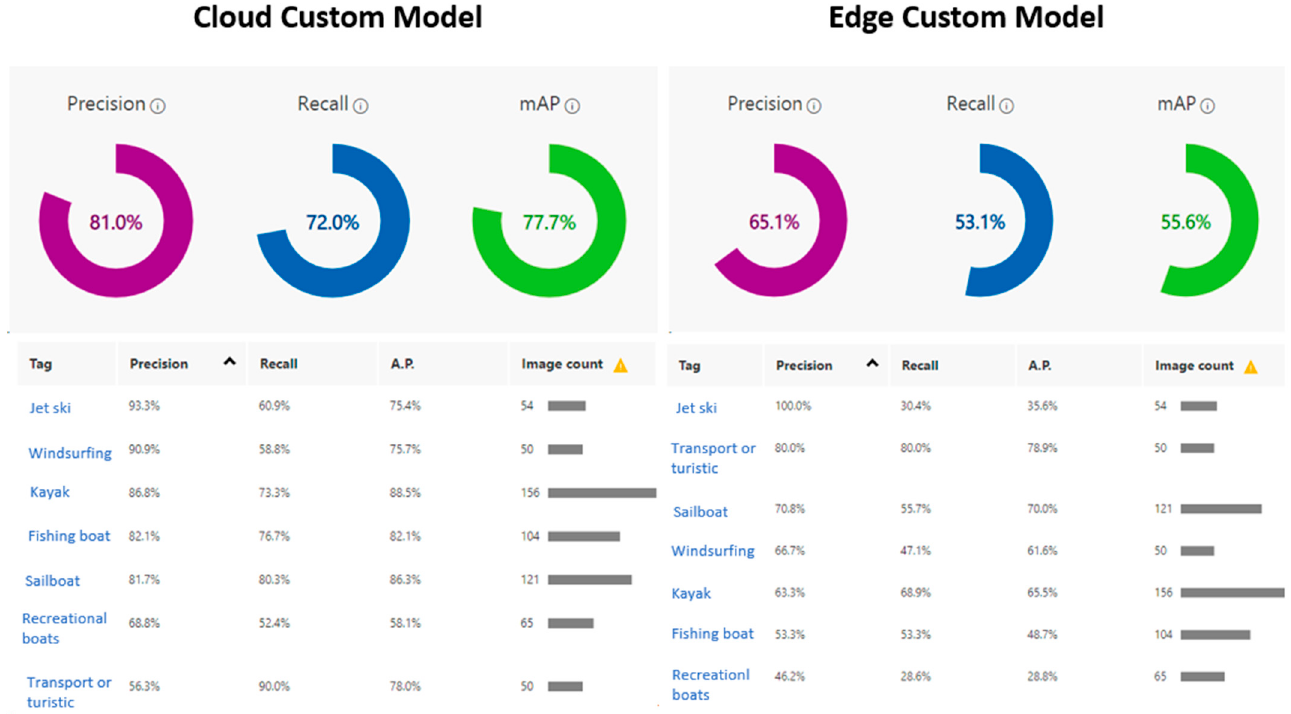
Figure 8. Performance differences between the edge and the cloud custom models